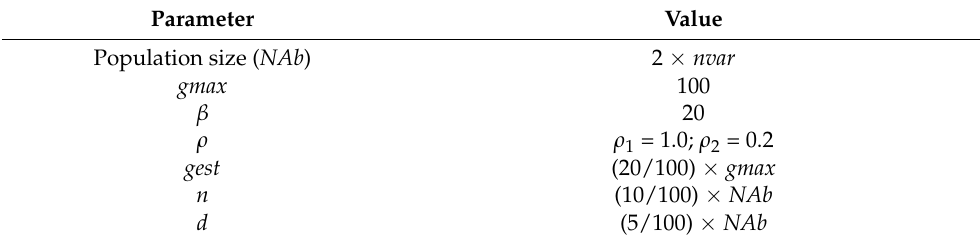
Table 2. MOAIS Parameters.